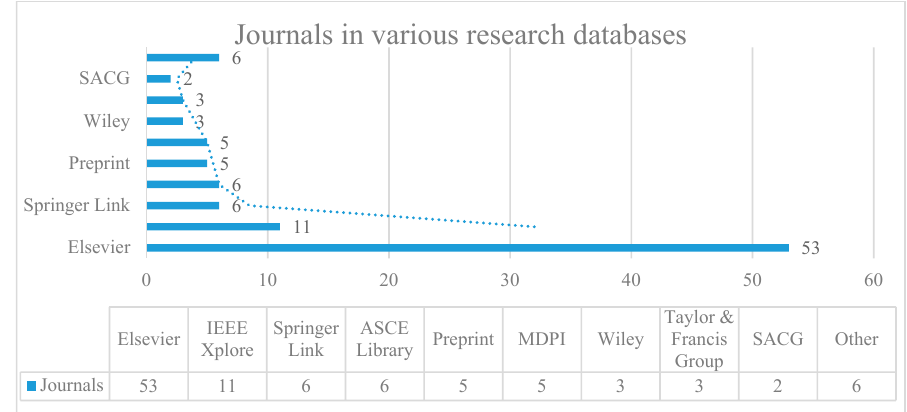
Figure 2. Number of journal publications investigated in different databases.